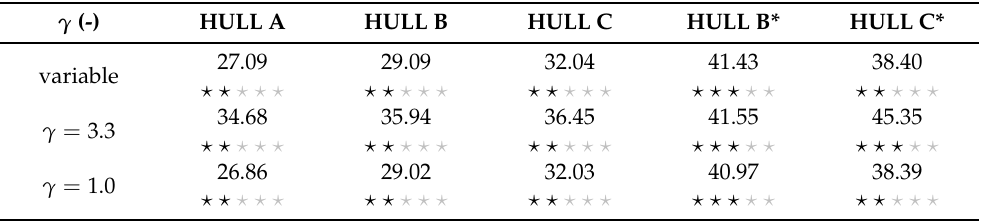
Table 6. OP C and comfort ratings according to different γ definitions for JONSWAP